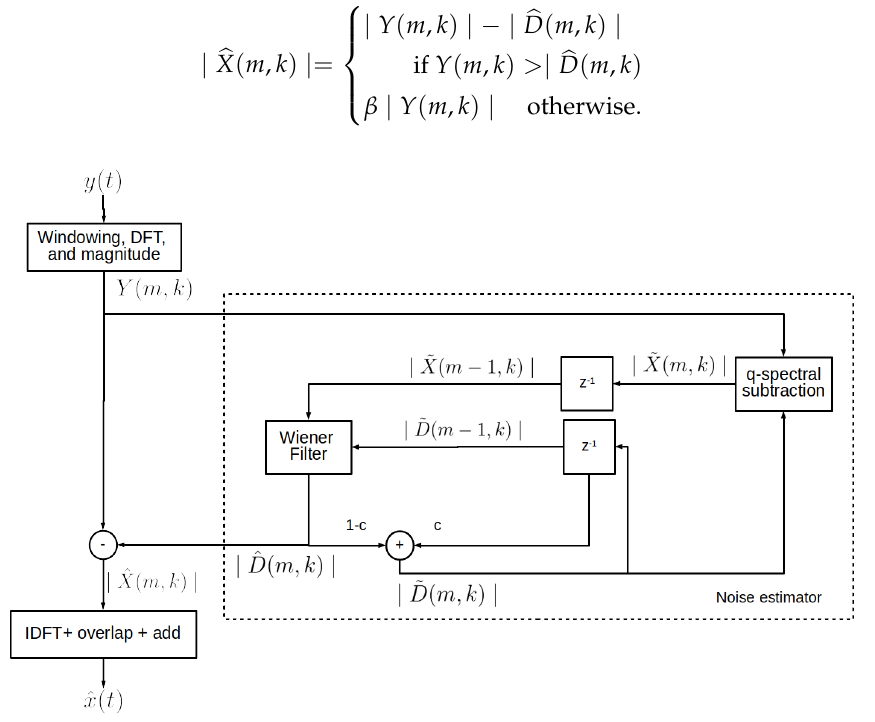
Figure 1. The block diagram of the proposed